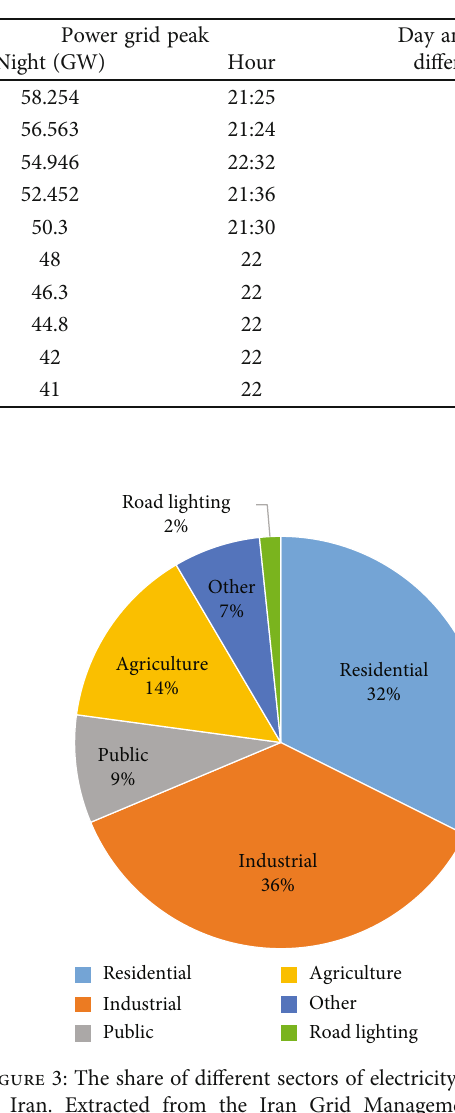
Table 1: Power grid peaks (hour and amount) in the last 10 years. Extracted from the Iran Grid Management Company (IGMC) and Tavanir Company